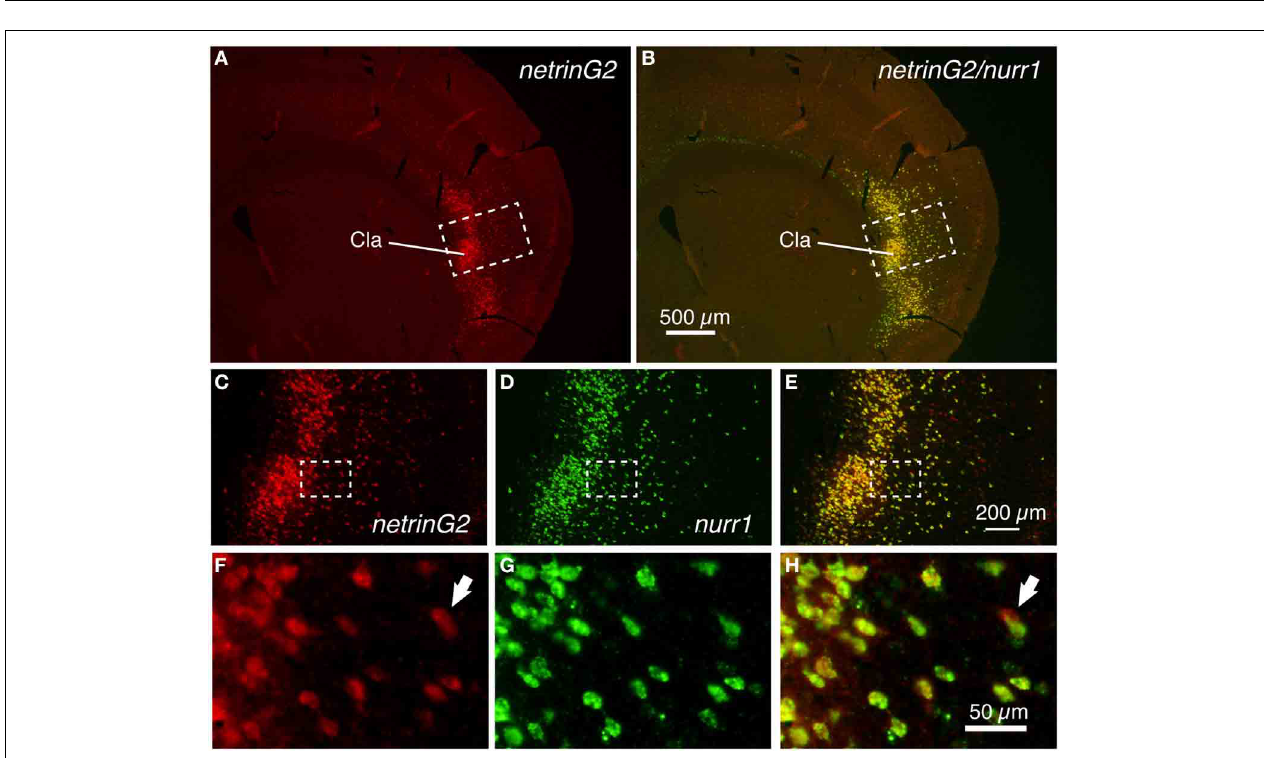
determined by the density of nuclear staining. (M–O) Dashed rectangles in (I–K) were magnified. Note exact colocalization of the two mRNAs in (O) . Cla, claustrum; hip, hippocampus; rf, rhinal fissure; S1BF, somatosensory barrel field; S2, secondary somatosensory area; St, striatum; Th, thalamus.